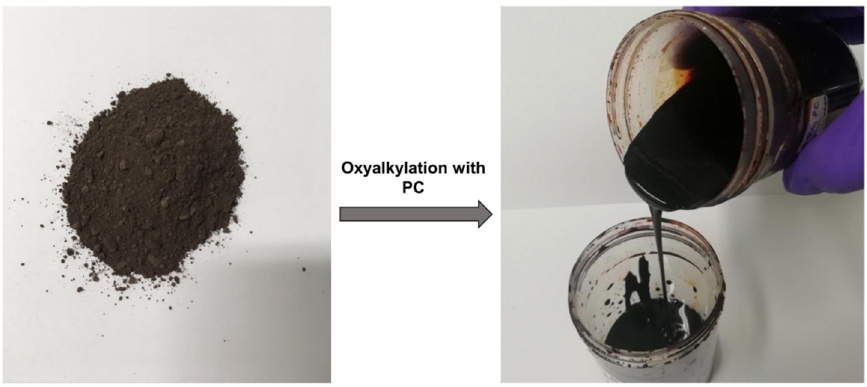
Figure 1. Kraft lignin and lignin-based polyol obtained by oxyalkylation using PC.